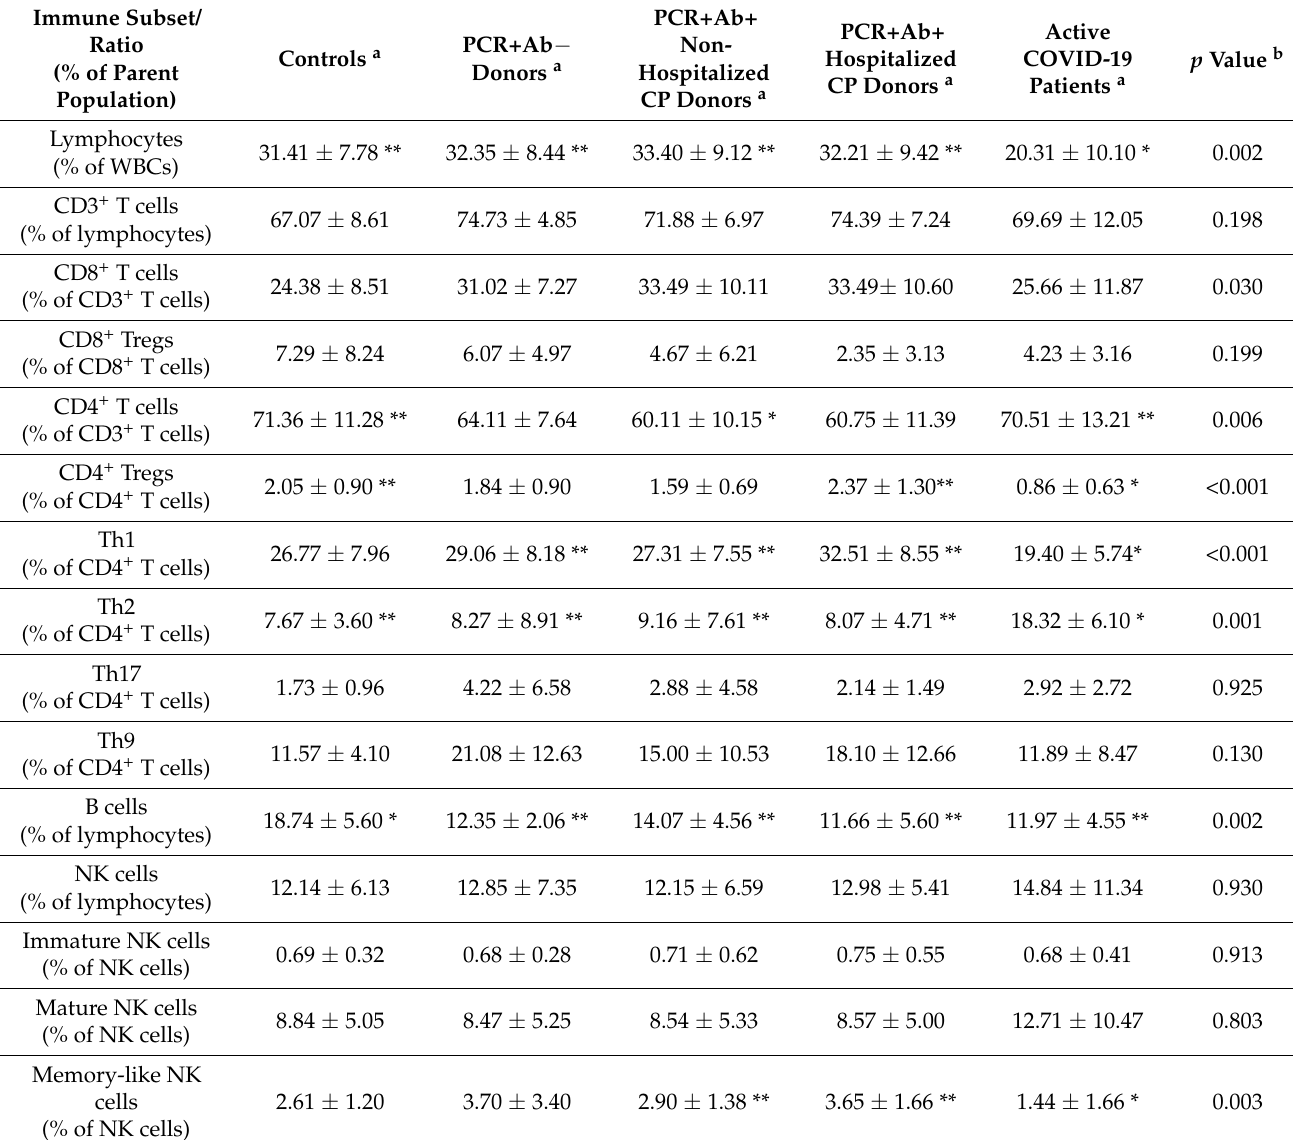
Table 3. Mean percentages of immune cell populations and cell ratios with the relative statistical significance of differences between